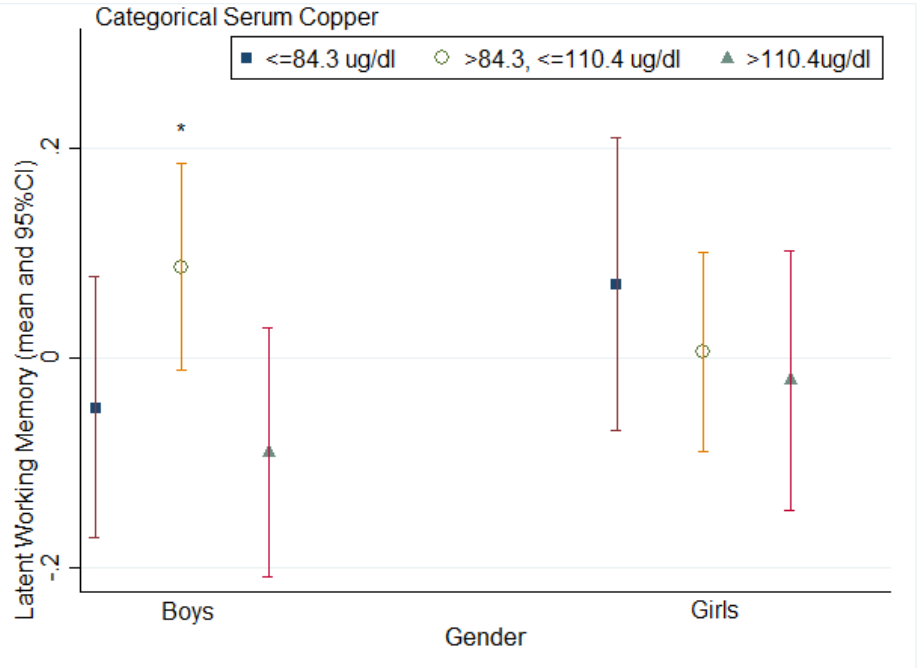
Figure 2. The mean and confidence interval of dot memory score by sex and serum copper level (Q1: ≤84.3 μg/dL, Q1–Q3: >84.3 μg/dL, ≤110.4 μg/dL, and Q3: >110.4μg/dL). * Significant difference between Q1–Q3: >84.3, ≤110.4 μg/dL and Q3: >110.4 μg/dL.